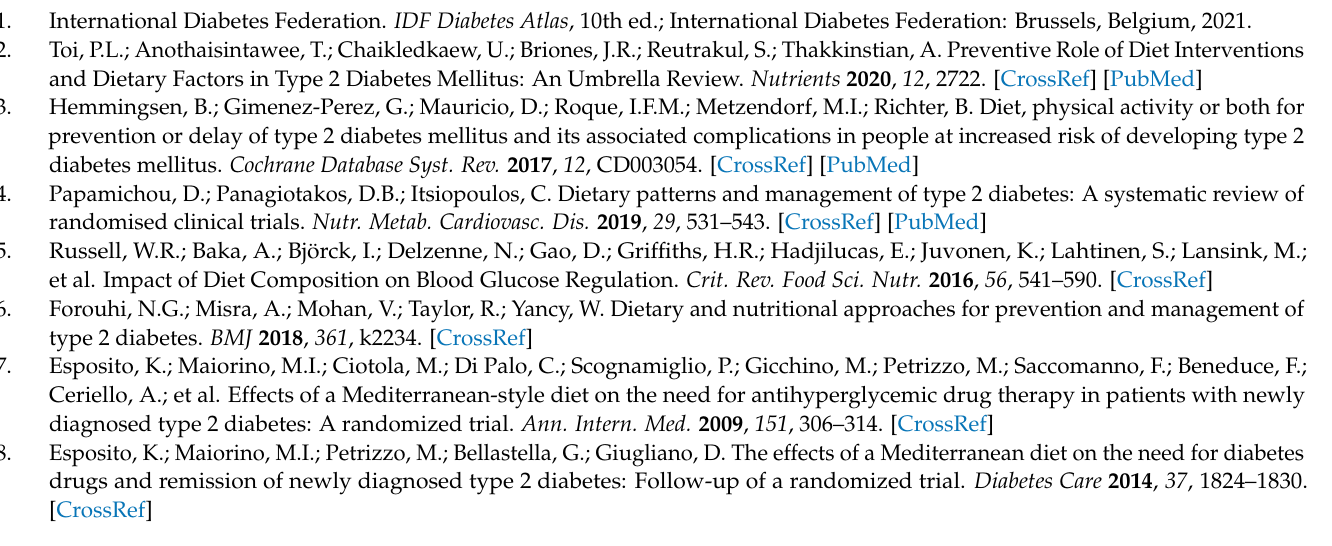
Usage Tendencies, Table S2: Fit Parameter Estimates for the Four Food Guidebook Usage Subgroups, Table S3: The BIC Results of the Dish Set Usage Tendencies, Table S4: Fit Parameter Estimates for the Three Dish Set Usage